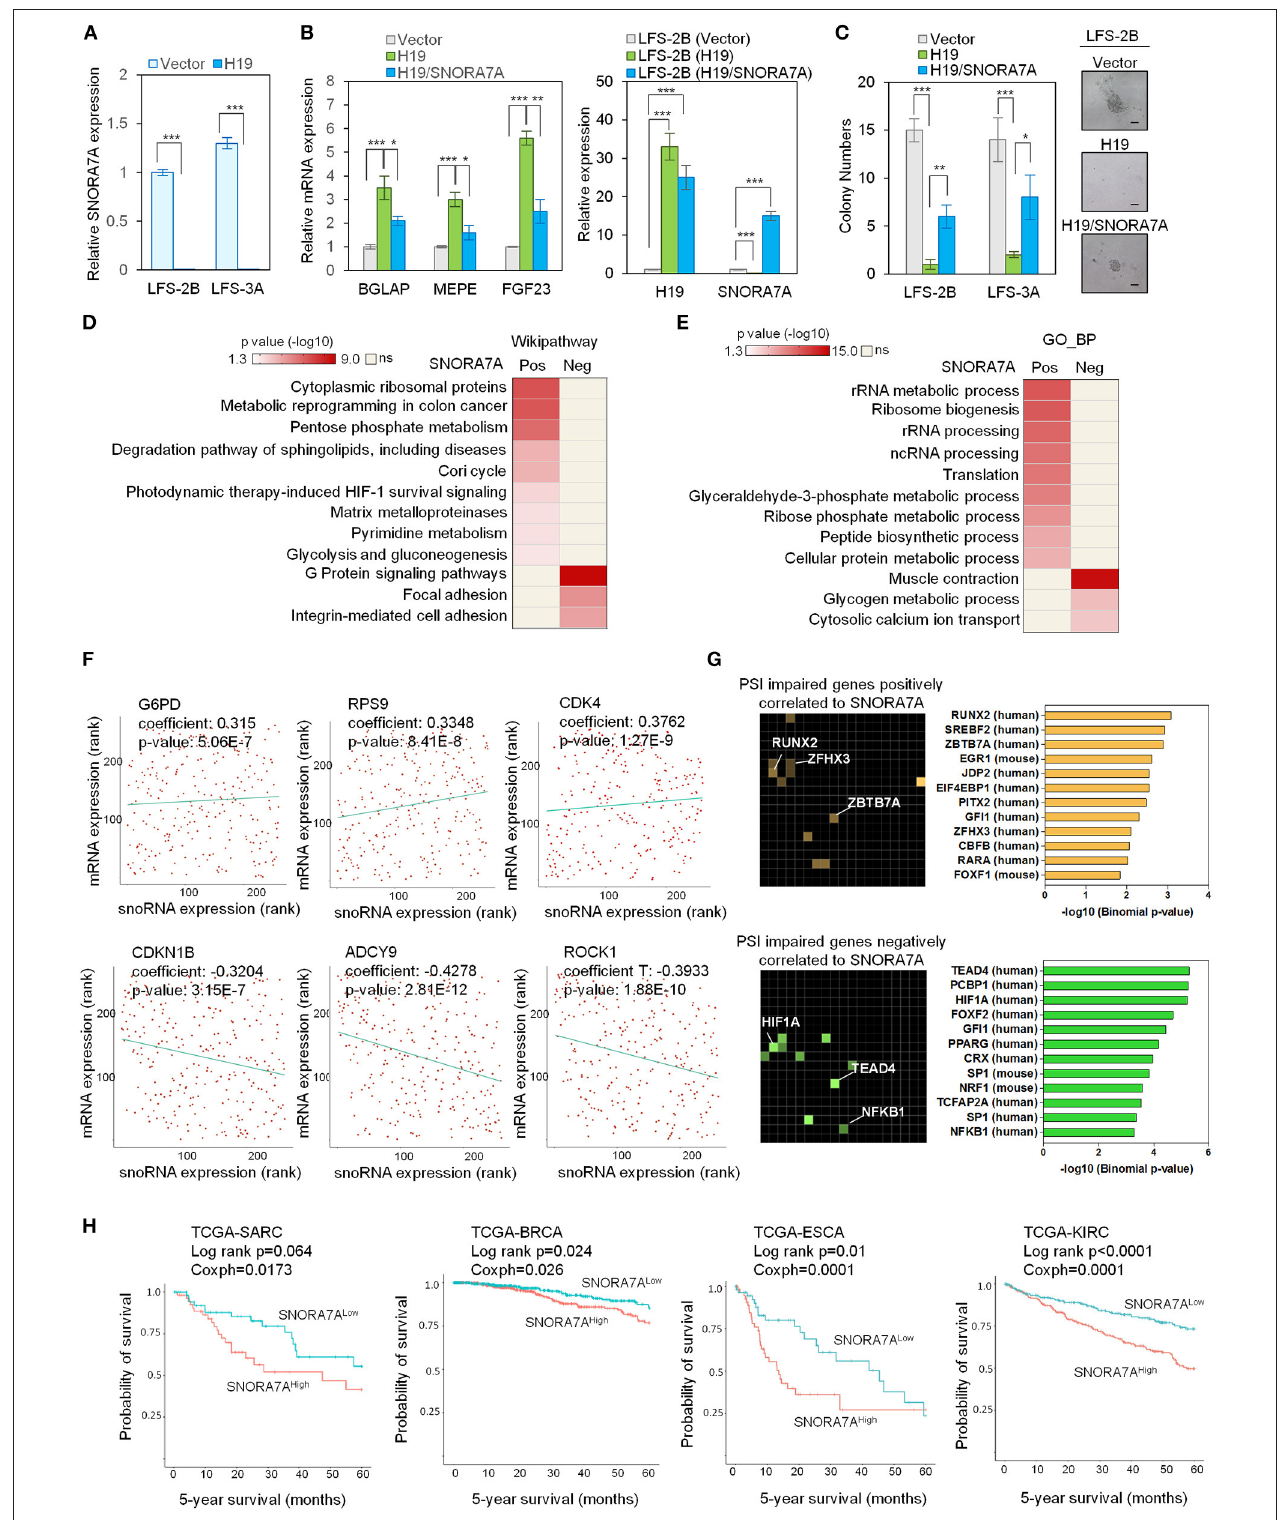
FIGURE 2 | Systems analyses of the oncogenic role of SNORA7A from TCGA datasets. (A) Ectopic expression of H19 downregulates SNORA7A expression in LFS osteoblasts. qRT-PCR data are represented as mean ± SEM; n = 3 biological replicates; statistical significance is determined using two-tailed Student’s t